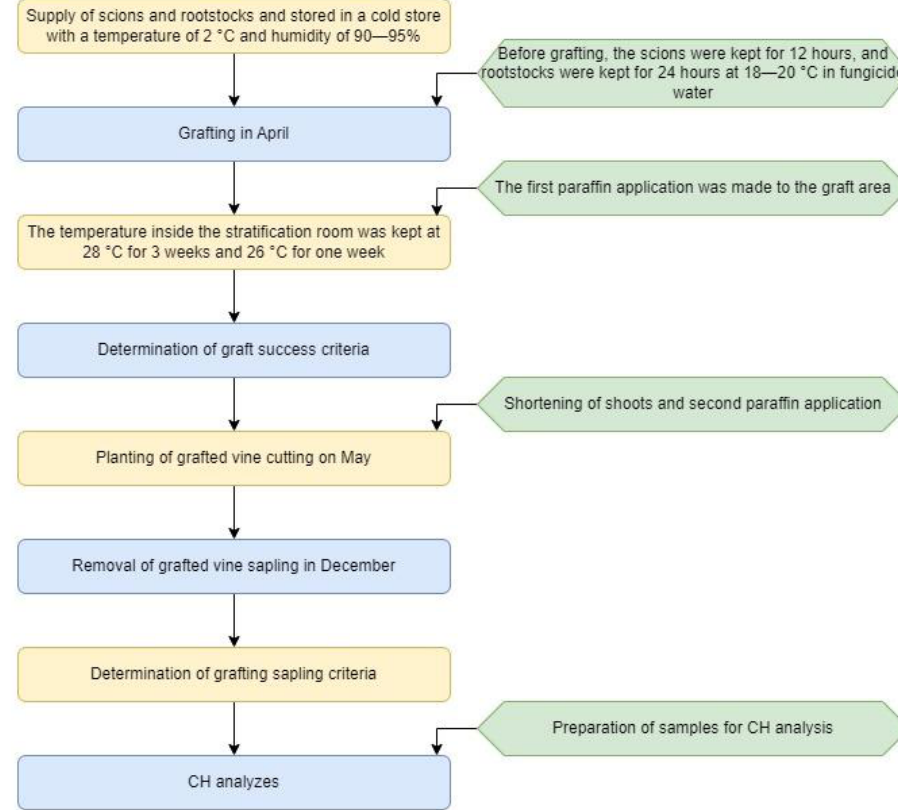
Figure 1. Grafted vine sapling production and analysis stages.